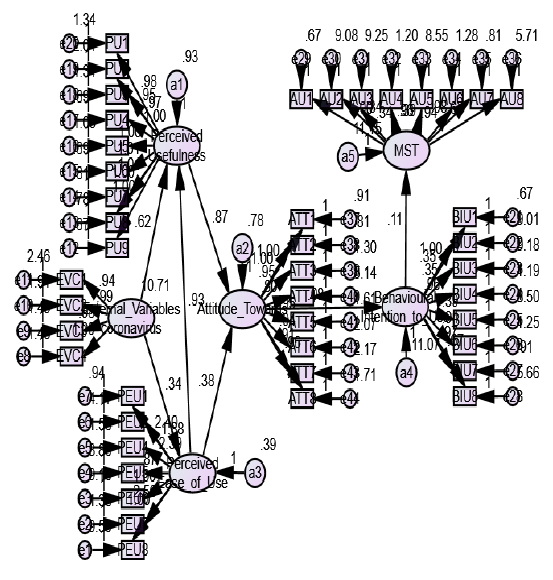
Fig. 2. Path Diagram of the Structural Model